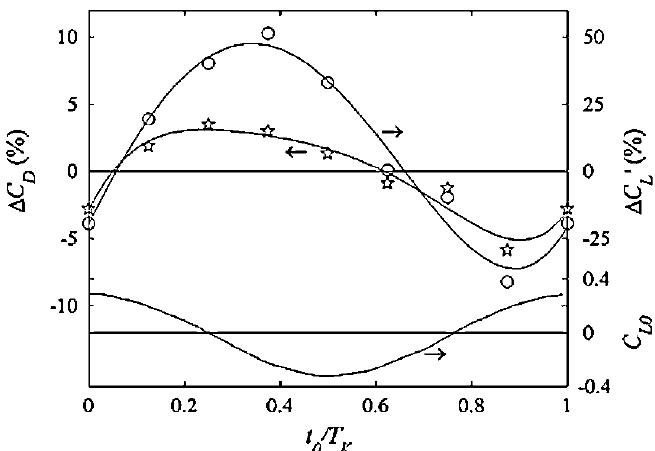
decrease in the drag and lift fluctuations as well as in the short-time-averaged mean drag.